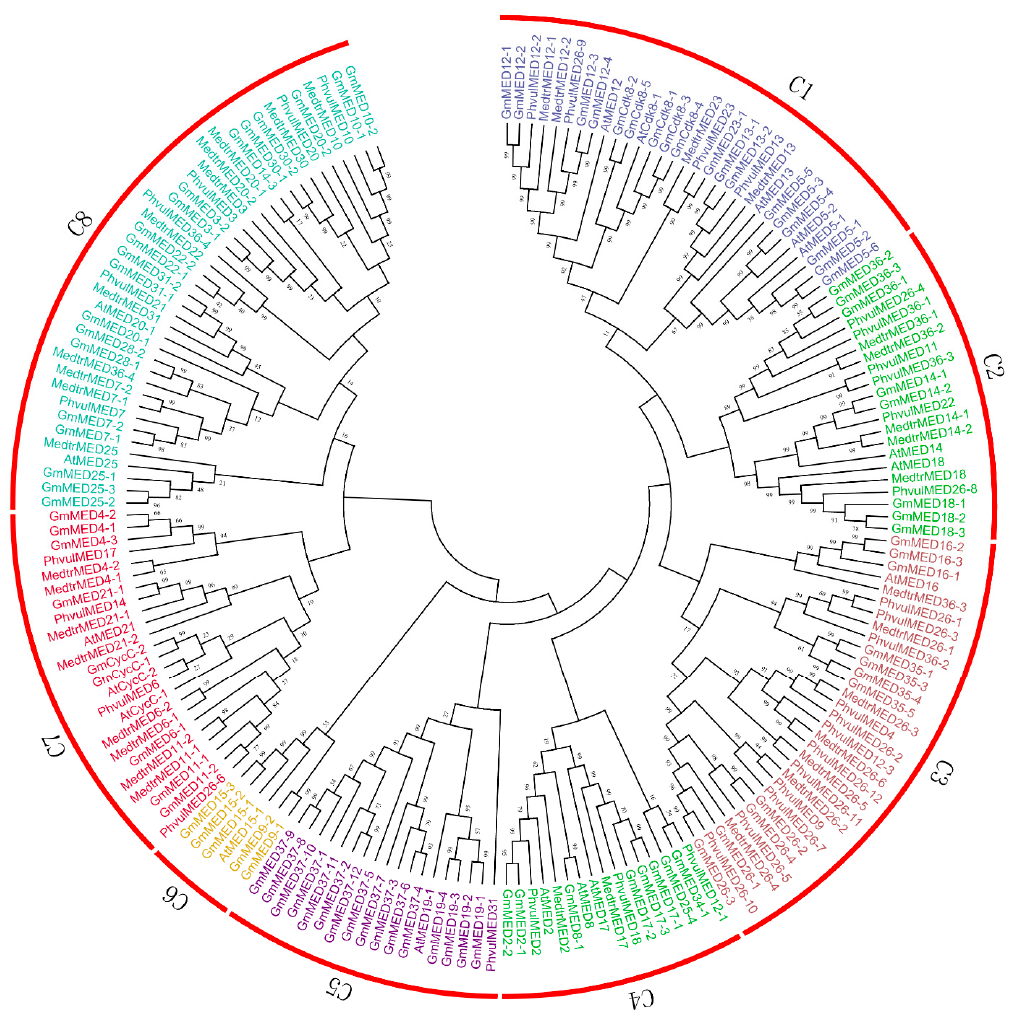
Figure 2. Phylogenetic tree for mediator complex subunits of soybean, Arabidopsis , Phaseolus vulgaris , and Medicago truncatula . The phylogenetic tree was constructed by MEGA 6.0 using the Neighbor-Joining method. The evolutionary distances were computed using the p-distance method. Bootstrap values in percentage (1000 replicates) are indicated on the nodes. Different subfamilies are highlighted using different colors and marked with red arcs outside of the cycle tree.